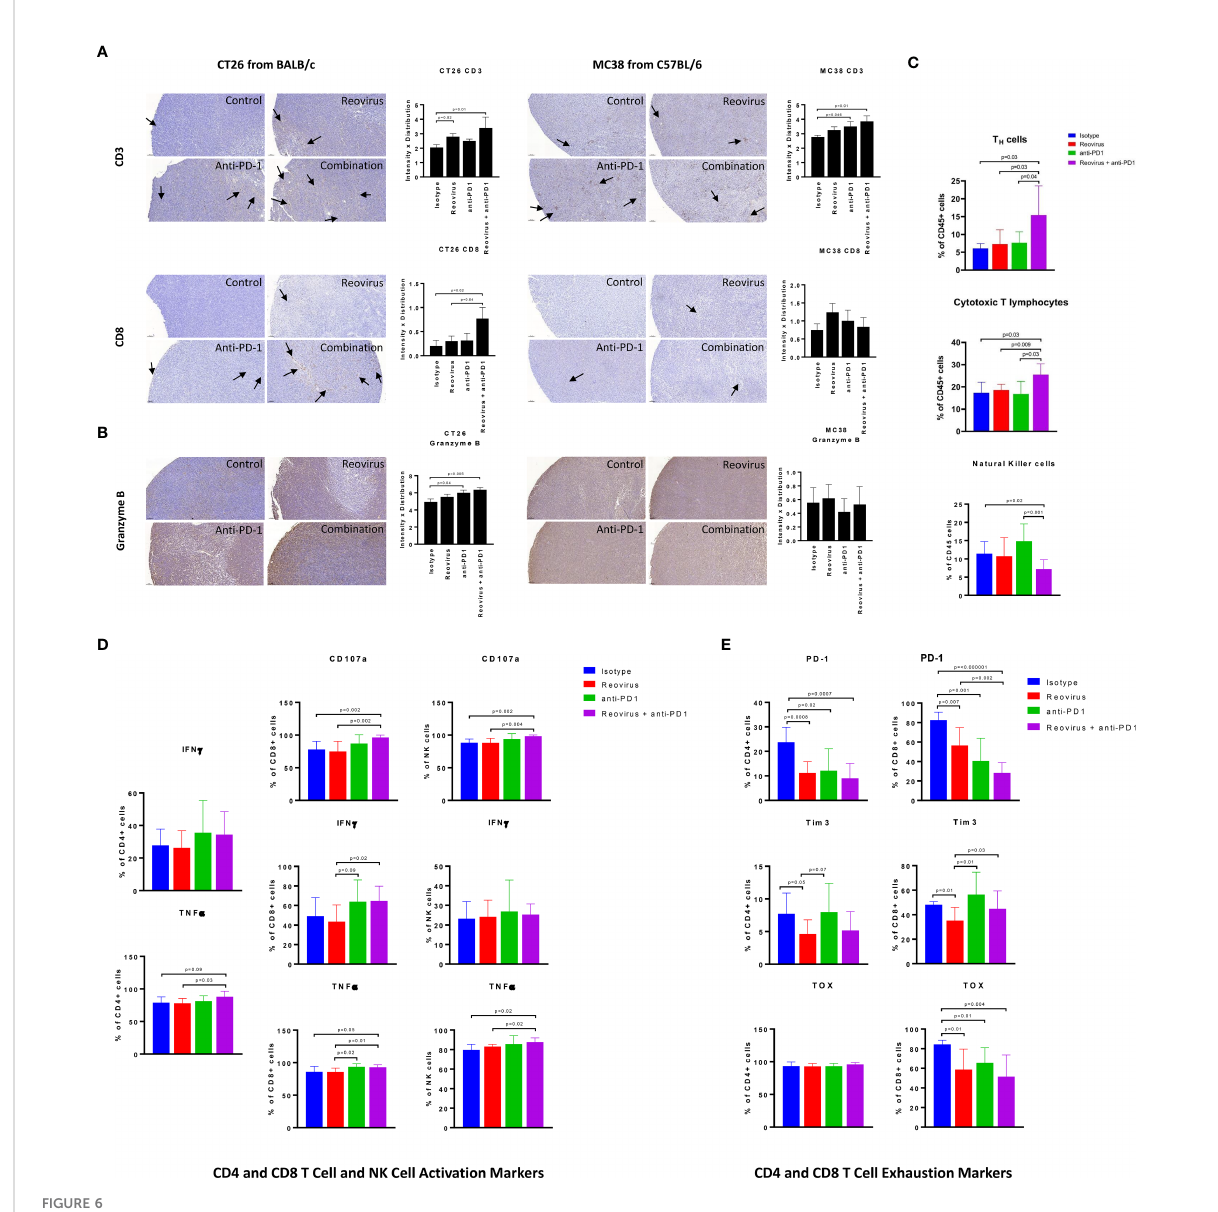
FIGURE 6 Difference in localization, distribution and expression of cell surface and activation/exhaustion markers in CD4 + and CD8 + T cell populations upon reovirus and anti-PD-1 treatment. (A) Reovirus in CT26, anti-PD1 in MC38, the combination treatment in both models increased the expression of CD3 (p=NS vs control). While overall, weak distribution, CD8 + T cell staining was increased upon reovirus (p=0.04) and combination treatment (p=0.03) speci fi cally in CT26. (B) Granzyme B, which is a functional marker of NK cells also, increased upon treating with reovirus (p=NS) and combination (p=0.03) in CT26. Overall granzyme B distribution, while high, we didn ’ t observe any signi fi cant difference among groups in MC38. (C) While single agent treatments displayed insigni fi cant role, combo increased CD4 + and CD8 + , and reduced NK cells among overall CD45 + cell populations in CT26. Strikingly enough, the increment among NK cells boosted by anti-PD-1 abrogated by reovirus administration (p=NS with reovirus). (D) Despite overall activation of CD4 + and CD8 + T cells, signi fi cantly increased expression of surface markers (CD107a, IFN- g and TNF- a ) observed only among CD8 + cells upon treatment with reovirus plus anti-PD-1. Anti-PD-1 single agent treatment seemingly increasing the expression of all markers, except TNF- a in CD4 + T cells. While anti-PD-1 alone increased CD107a, IFN- g and TNF- a expression (p=NS) among NK cells, combination treatment signi fi cantly increased only CD107a. Reovirus treatment didn ’ t make differences in expression in any of the cytokines studied among NK cell populations. (E) Single agents and combination treatment largely reduced the expression of exhaustion markers, however, CD4 + TOX among all groups and Tim3 among CD4+ and CD8 + T cells after anti-PD-1 treatment. Noticeably, Tim3 expression among CD8 + T cells were increased upon anti-PD-1